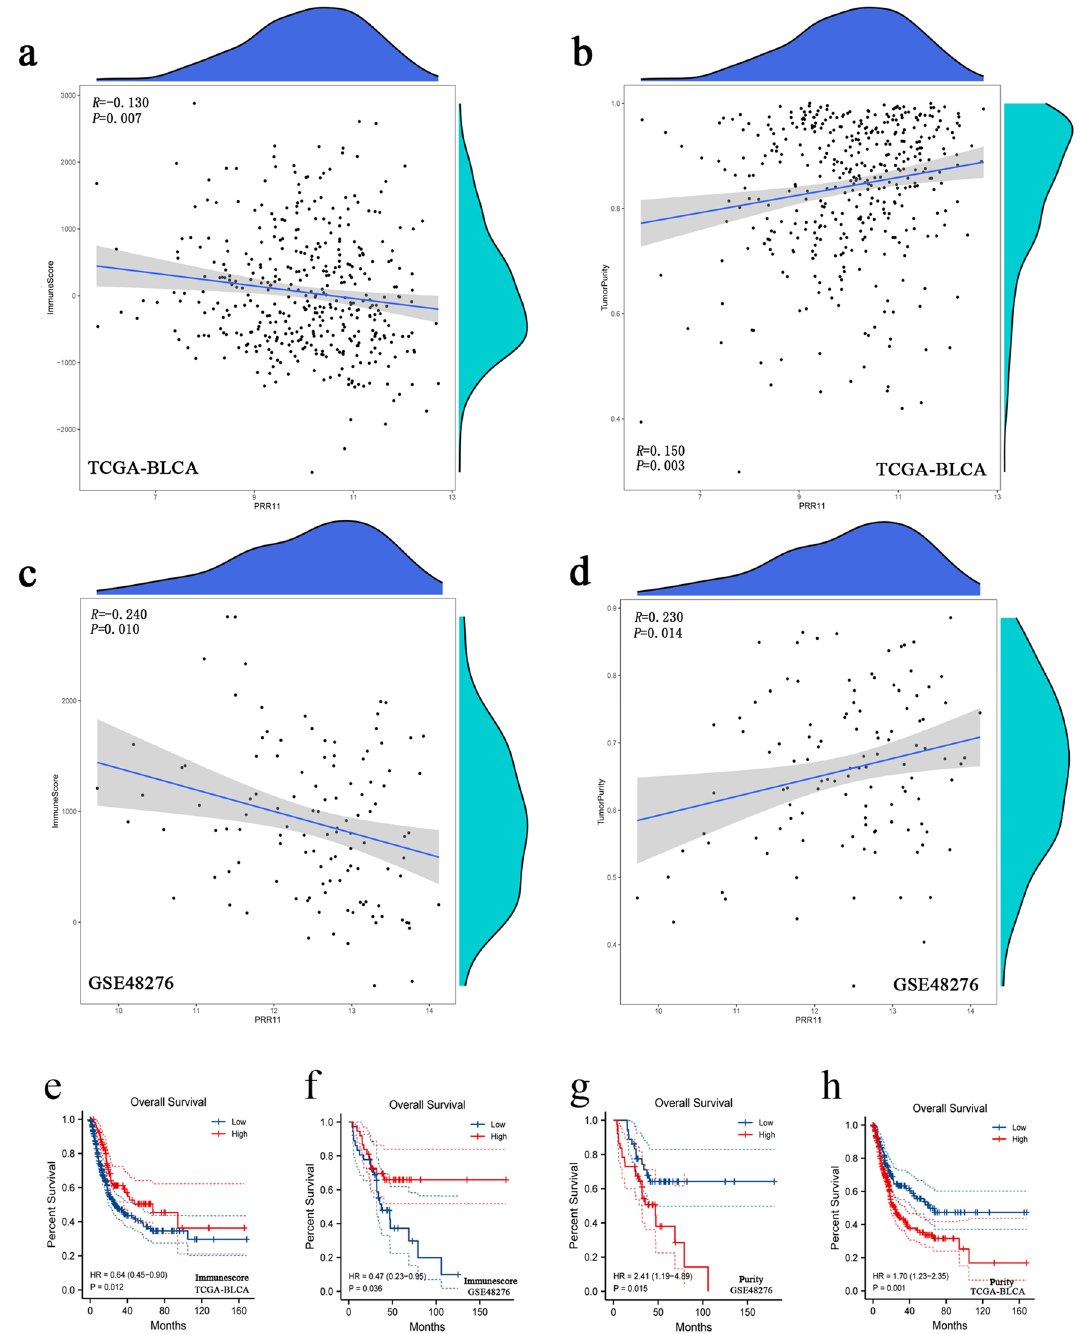
Figure 8. Associations between the PRR11 expression and immune infiltration level in BLCA from the ESTIMATE algorithm. ( a – d ) The expression of PRR11 has a significant negative correlation with the immunescore and a positive correlation with tumorpurity score of BLCA samples based on the ESTIMATE algorithm in the TCGA-BLCA and GSE48276 dataset. The horizontal axis in the figure represents gene expression, and the vertical axis is purity/immunescore. The density curve on the right represents the distribution trend of purity/immunescore; the upper density curve represents the distribution trend of genes. ( e – h ) Kaplan–Meier survival curves were used to analyze the correlation between purity/immunescore and OS of BLCA patients. Patients with higher immunescore and lower tumorpurity score have higher OS time in the TCGA-BLCA and GSE48276